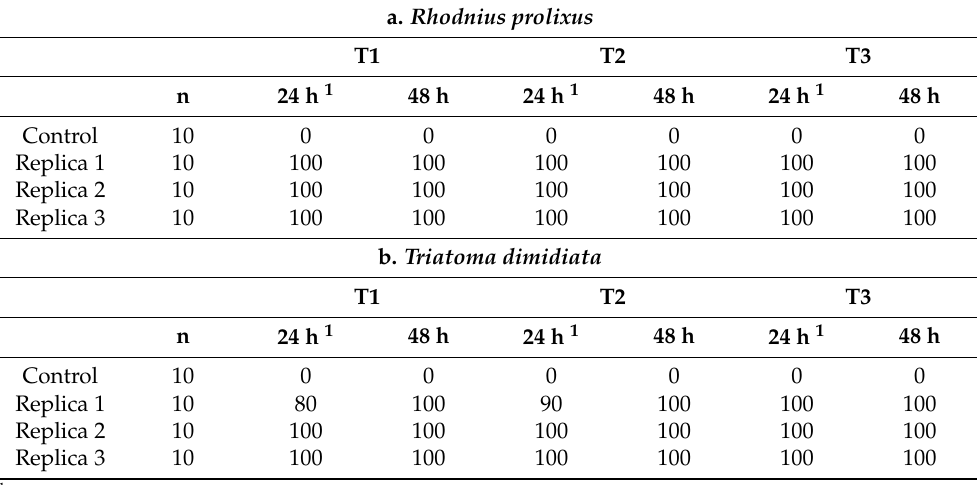
Table 1. Mortality% to treated and control chamber prototypes in R. prolixus and T. dimidiata for each application